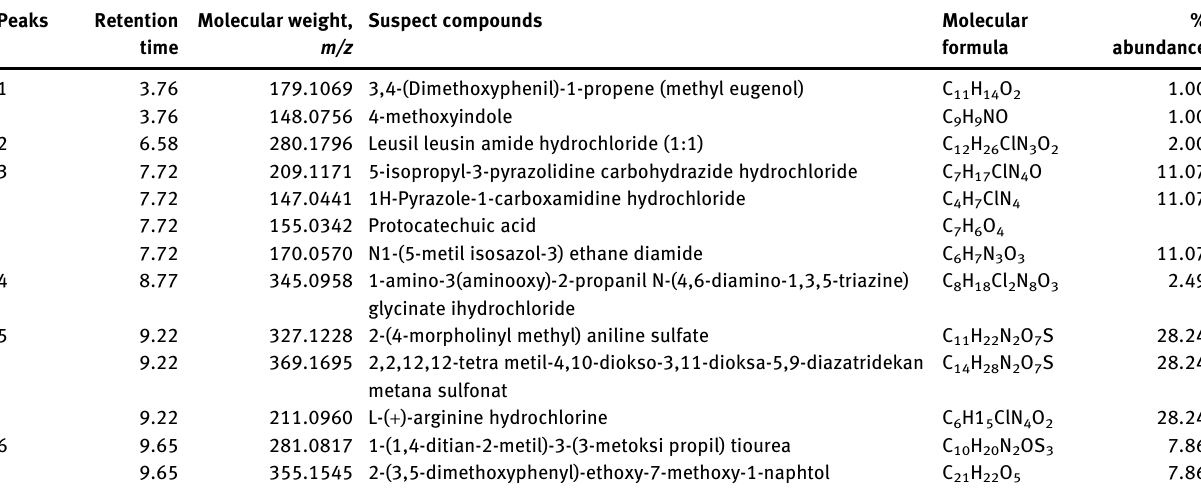
Table  : Bioactive compounds of n-hexane fraction by LC-MS analysis.